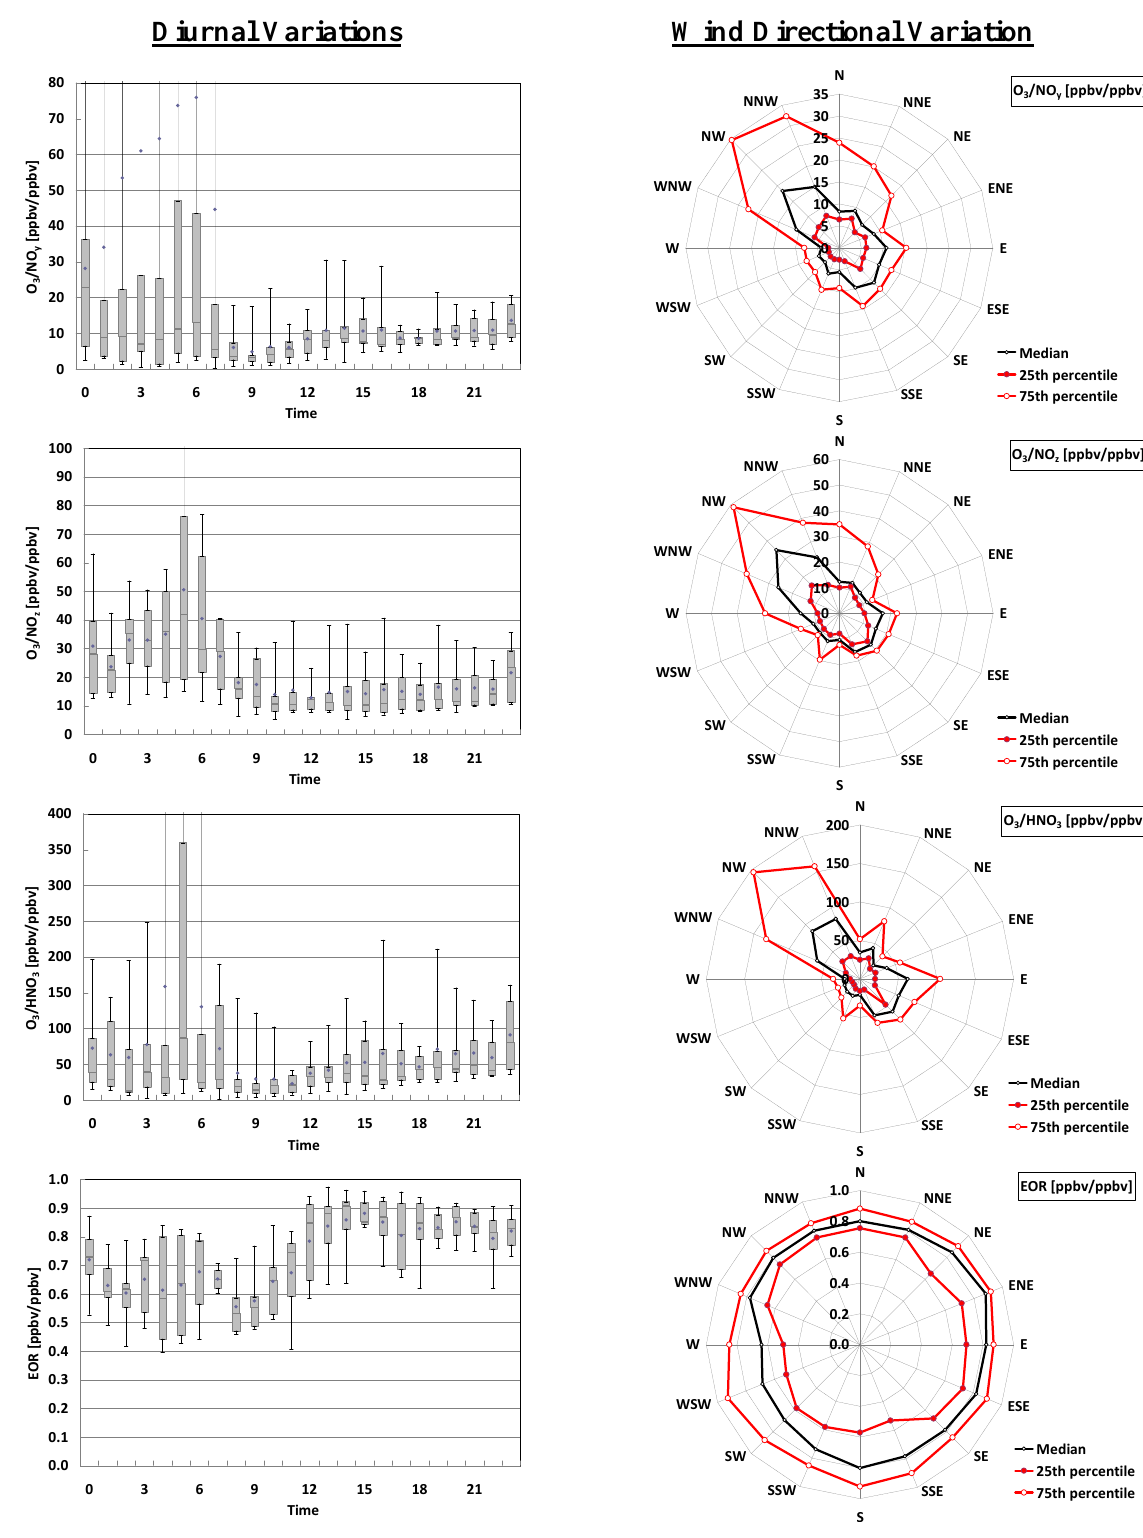
Figure 8. Diurnal and wind directional variation of photochemical indicators O 3 /NO y , O 3 /NO z , O 3 /HNO 3 and EOR on IOP days. Units shown in brackets for the wind directional variation plots refer to the radial direction of the corresponding trace gas